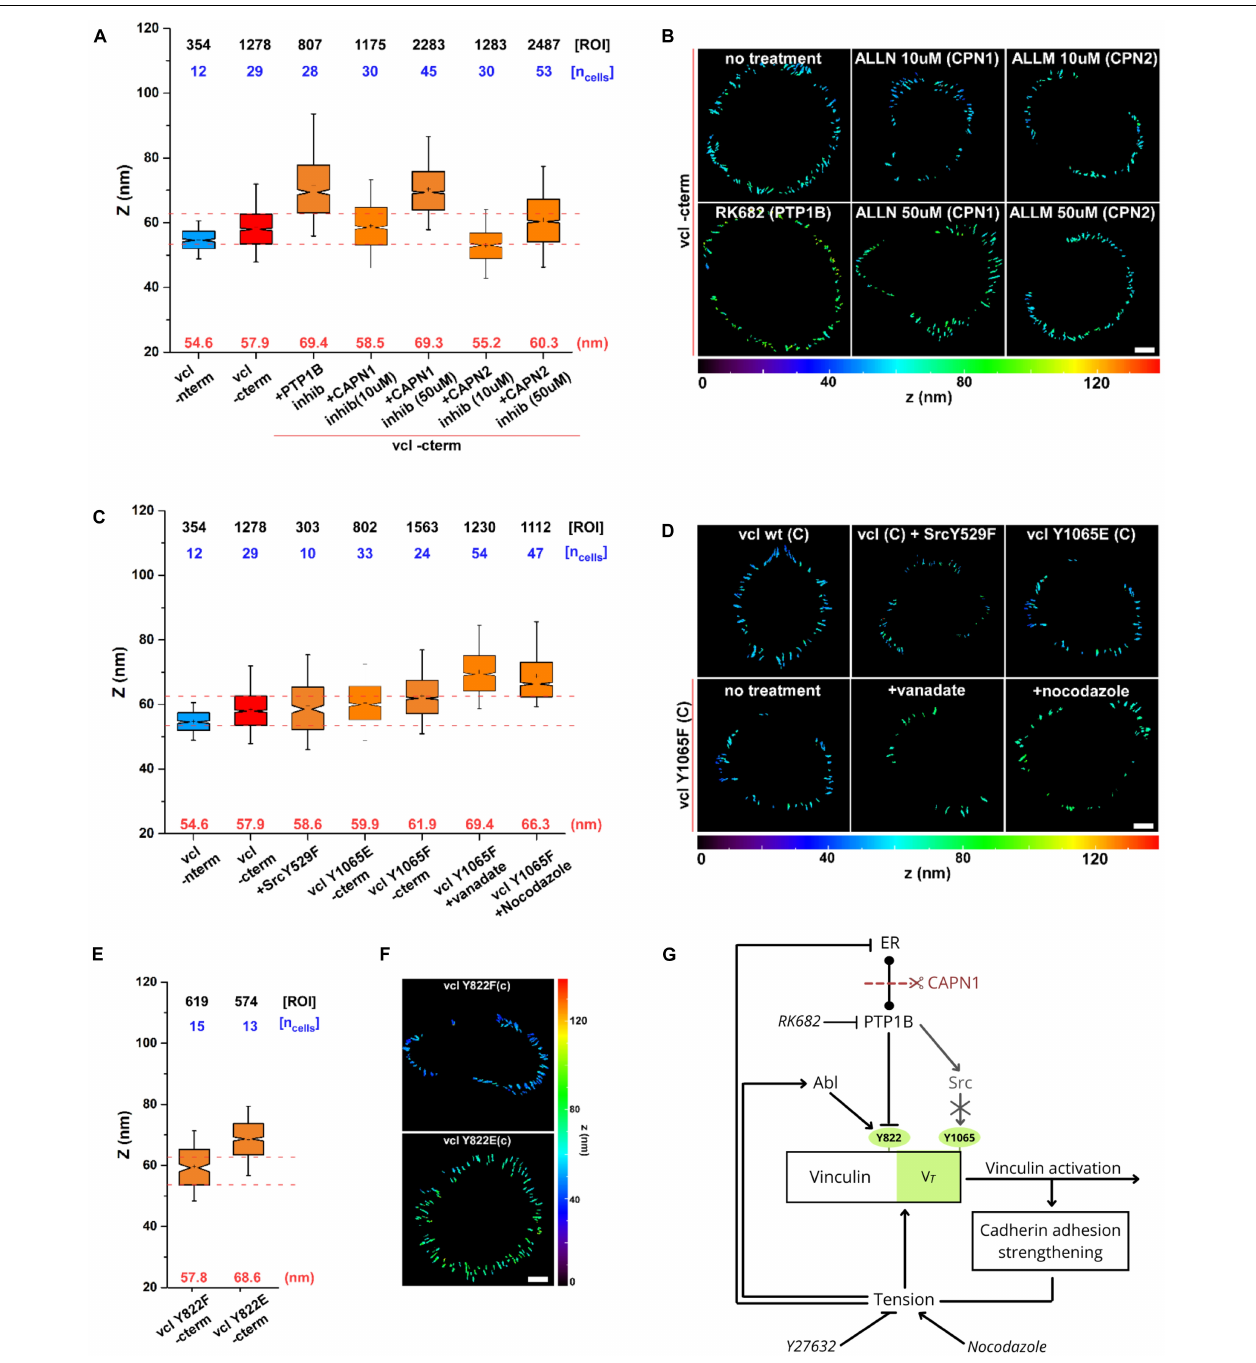
FIGURE 6 | Calpain, through activation of PTP1B, regulates vinculin conformational change. Scanning angle interference microscopy for vinculin Z-position in MDCK cells treated as follows: (A,B) no treatment, with PTP1B inhibitor (RK682 10 µ g/ml), with calpain-1 (CAPN1) inhibitor (ALLN, 10 and 50 µ M), and with calpain-2 (CAPN2) inhibitor (ALLM, 10 and 50 µ M); (C,D) in MDCK cells transfected with dominant active SrcY529F mutant and in MDCK vinculin KD cells with vinculin phosphomimetic mutant Y1065E and non-phosphorylatable mutant Y1065F, not treated and after drugs treatment (vanadate 10 µ M and nocodazole 10 µ M, 1 h). (E,F) Z-position of vinculin phosphomimetic mutant Y822E and non-phosphorylatable mutant Y822F. (A,C,E) Notched box plots for the Z-position of vinculin in E-cadherin-based adhesions. Notched box plots indicate first and third quartiles, median, and confidence intervals; whiskers, 5th and 95th percentiles. Median center values are indicated below each box plot (red). n values are shown above each box plot and indicate the numbers of adhesions (number of ROIs, black). Numbers of cells are indicated in blue. Red dotted lines indicate 5th and 95th percentiles of vinculin wt C-terminus for reference. (B,D,F) Topographic maps of protein Z-positions (nanometers) of the indicated proteins in E-cadherin-based adhesions of MDCK cells. Images were acquired by TIRF microscope with a 60x objective, 1.49NA Plan-Apo (Nikon). Scale bar, 5 µ m. (G) Diagram showing the dual mechanism by which tension can modulate vinculin conformational switch.